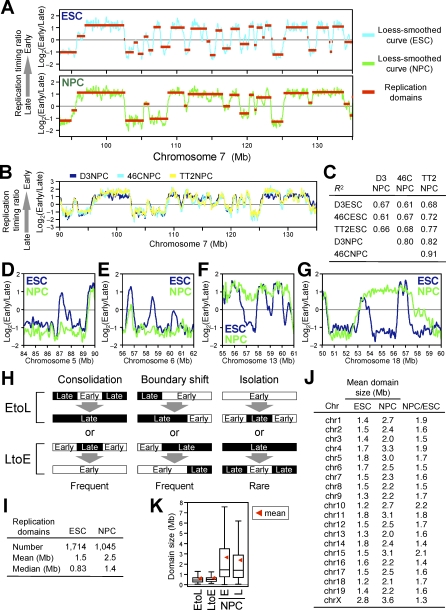
Global Reorganization of Replication Domains upon Differentiation of ESCs to NPCs(A) Replication domain profiles change dramatically upon differentiation of ESCs to NPCs. An exemplary Chromosome 7 segment is shown.(B and C) NPCs derived from distinct neural differentiation schemes and three independent mESC lines showed fairly similar replication timing profiles, both by visual inspection (B) and high Pearson R
2 values for pair-wise comparisons of NPCs (C). The low R
2 values for pair-wise comparisons of ESCs and NPCs confirm that substantial changes occurred upon differentiation (C).(D–G) Exemplary EtoL (Early-to-Late) (D and E) and LtoE (Late-to-Early) (F and G) consolidation.(H) Schematic representation of domain consolidation, boundary shift, and isolation.(I) Summary of replication domain properties in ESCs and NPCs.(J) Replication domain sizes by chromosome. Chromosome Y was underrepresented on the microarray and was excluded from the analysis.(K) Box plots of sizes of domains that changed replication timing (EtoL and LtoE), as well as early- and late-replicating domains in NPCs. EtoL and LtoE domains show smaller and tighter distribution than domains in NPCs or ESCs (Figure 2B).